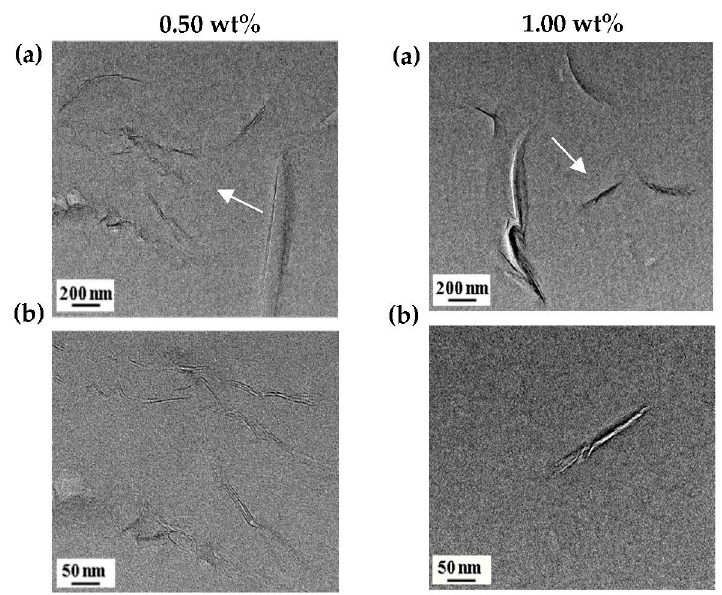
Figure 6. TEM micrographs of BAS-OH hybrid films containing 0.5 wt% and 1.00 wt%. Cloisite 30 B with increasing magnification levels from ( a ) to ( b ).